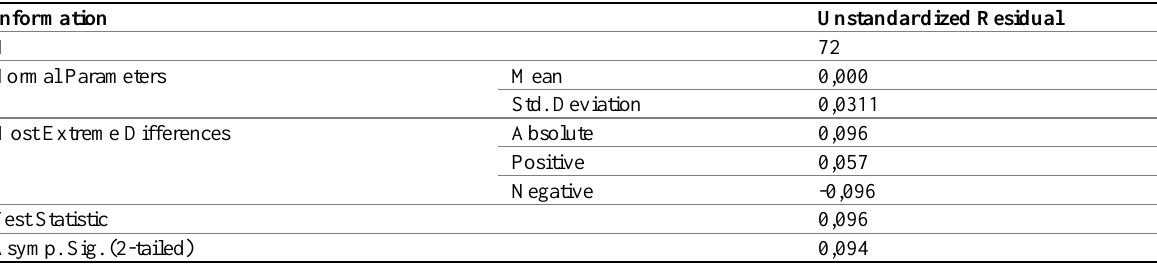
Table 4: The Result of Normality